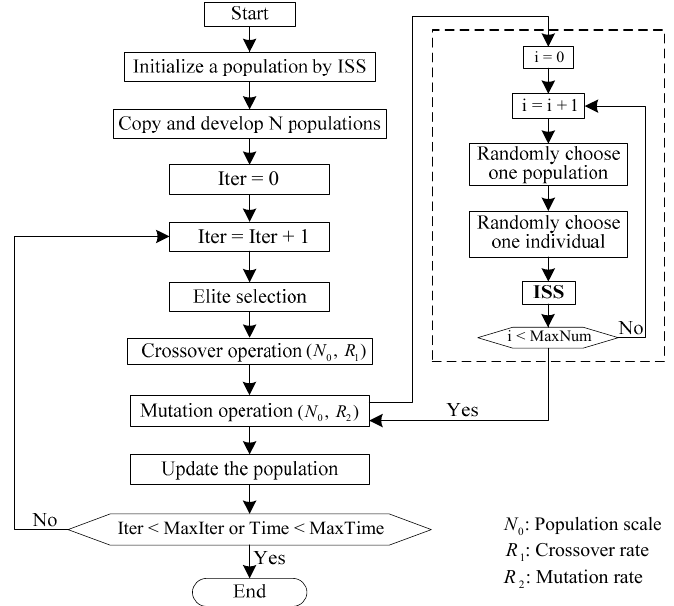
Figure 4. A genetic algorithm (GA)-ISS based hybrid method.